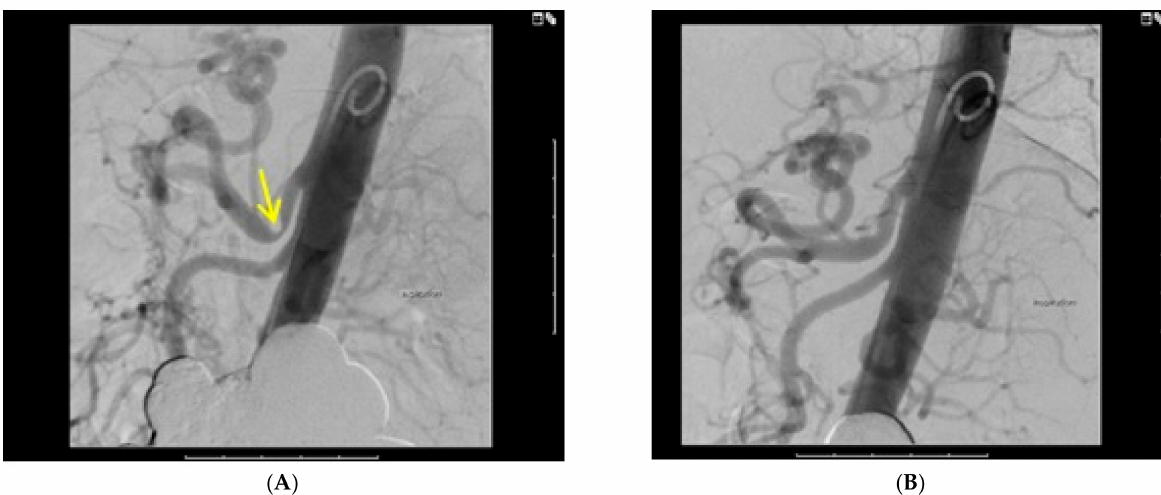
Figure 2. Lateral views of abdominal aortogram demonstrating the respiratory variations in celiac artery compression at its origin by the median arcuate ligament. ( A ) Expiratory Phase with more than 60% compression (yellow arrow) and characteristic distal dilation of celiac trunk just past the narrowed segment. ( B ) Inspiratory Phase with less than 30% compression. (Reproduced from McCallum et al. [4] with permission from Practical